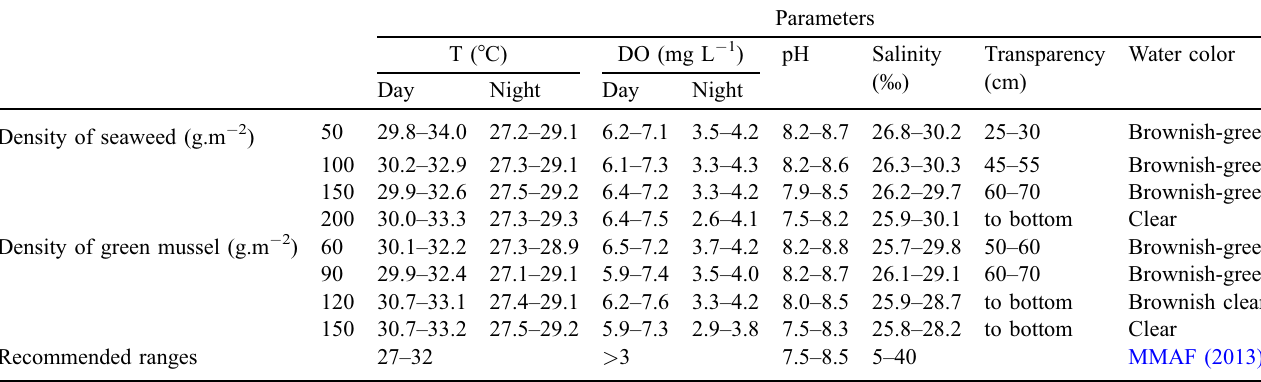
Table 2. The ranges of observed temperatures (T), dissolved oxygen (DO), pH, salinity, transparency and color of the water in the 8 treatments with 4 densities of both seaweed and green